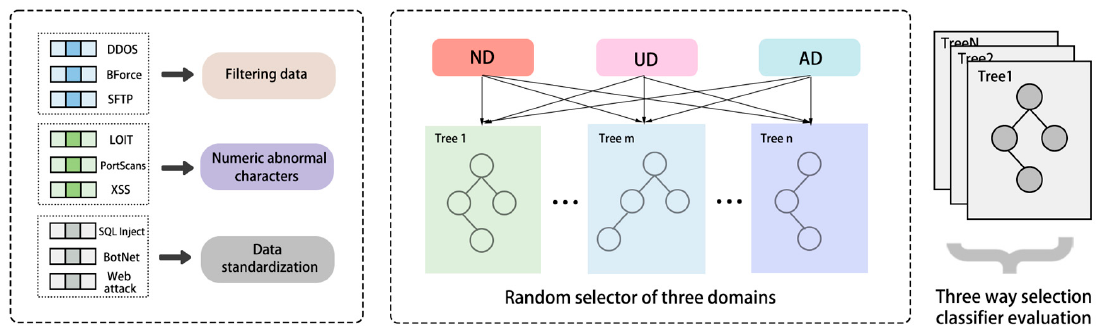
Figure 2. Overall framework of three-way selection random forest optimization model.